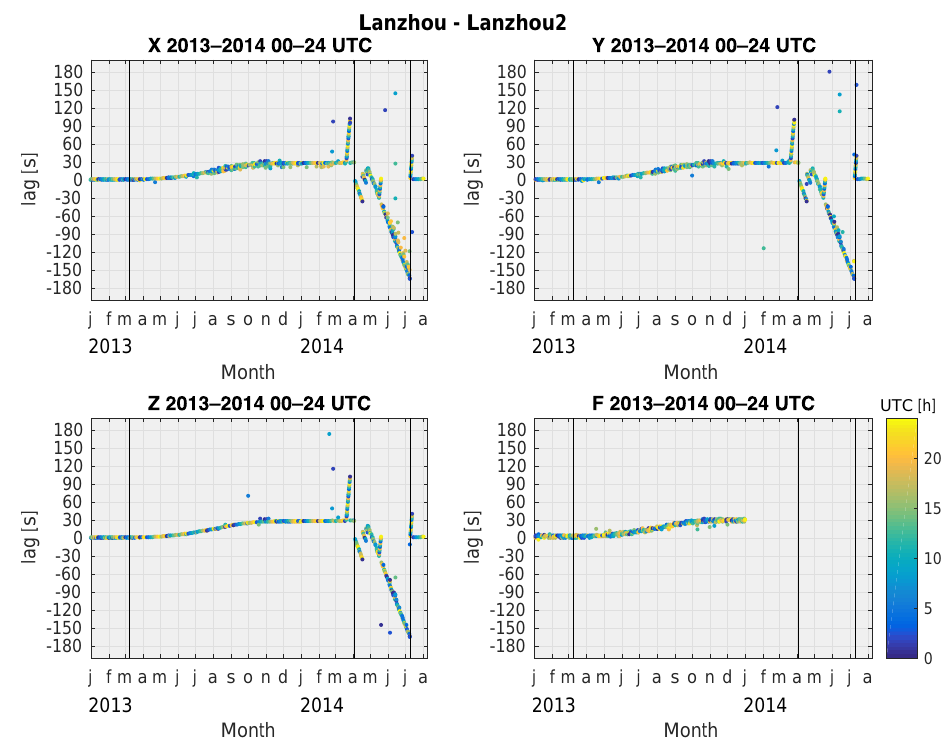
Figure 4. Time lags calculated for every hour using the data of the two acquisition systems available at Lanzhou observatory for each component of the magnetic field X,Y,Z and F . The F component is measured every 5s at Lanzhou; the second scalar magnetometer was not available in 2014. The vertical lines indicate from left to right: the time when the GPS synchronization became unavailable, the time when the data logger was rebooted and the time when the GPS synchronization was re-established.